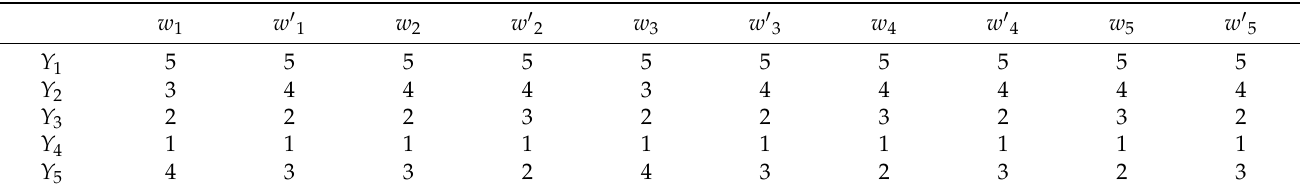
Table 4. Sensitivity analysis of alternative ranking on the basis of fluctuation in the weights of criteria.